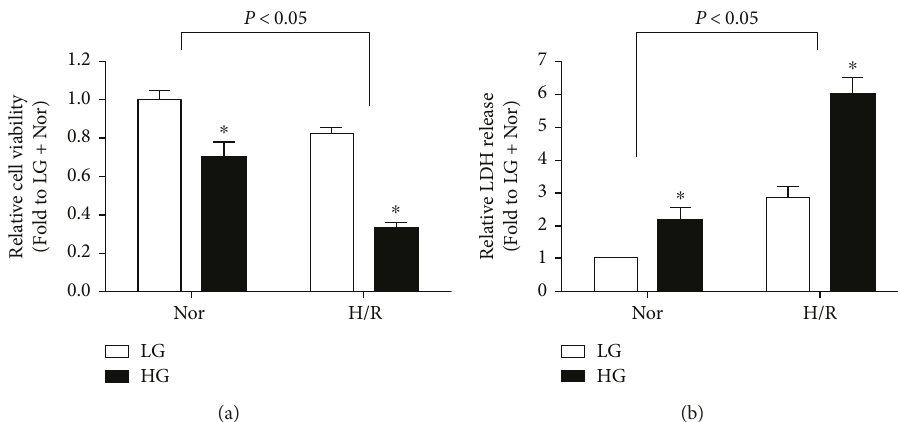
Figure 1: E ff ects of high glucose (HG) and hypoxia/reoxygenation (H/R) on cellular viability (a) and the release of LDH (b) in H9C2 cells. All the results are expressed as mean ± SD ( n = 8 ). Di ff erences were determined by using two-way ANOVA followed by Tukey ’ s post hoc test. ∗ P < 0 05 versus LG (low glucose) group in normoxic or hypoxic